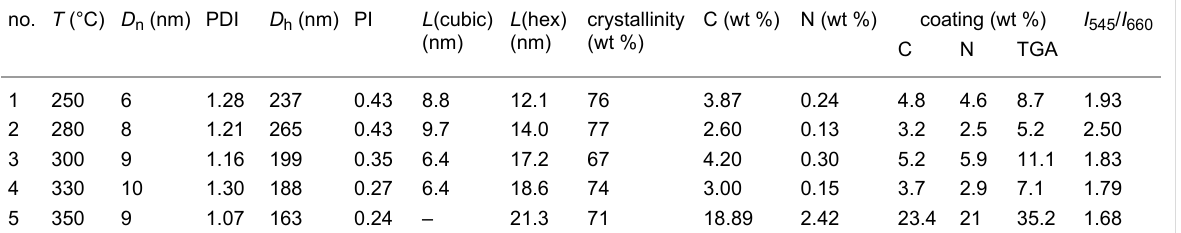
Table 1: Effect of reaction temperature on OM–NaYF 4 :Yb 3+ /Er 3+ nanoparticles prepared for 1 h. no. T (°C) D n (nm)